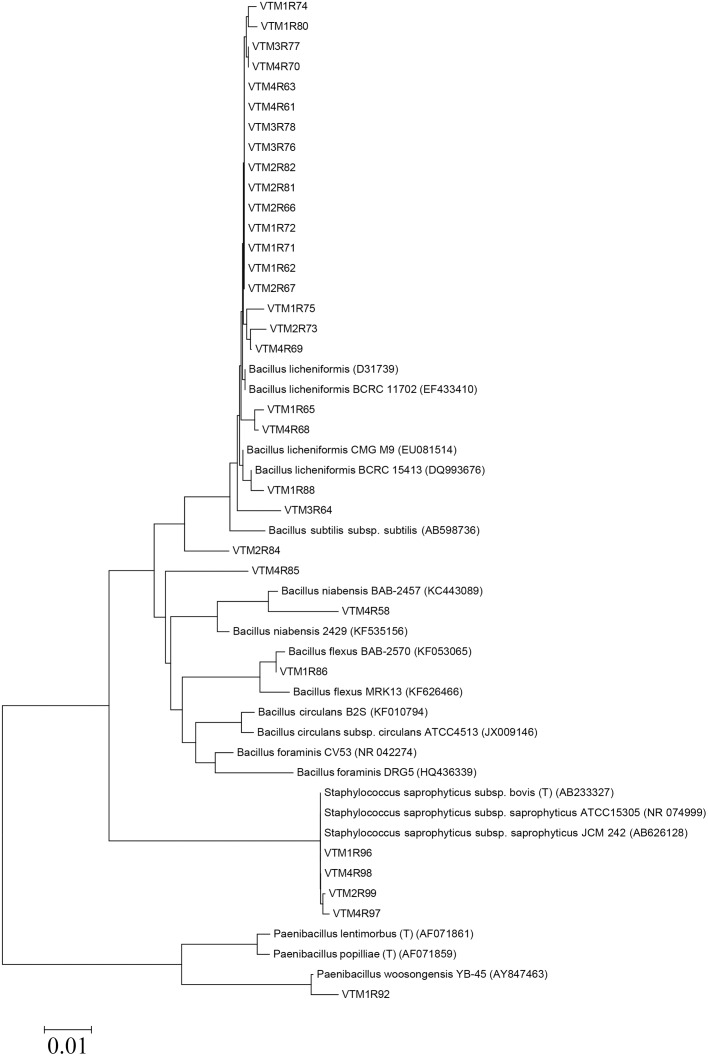
Phylogenetic comparison of 31 fibrolytic isolates along with known sequences (NCBI).A neighbor-joining tree was created using MEGA ver. 6 and the Kimura 2-parameter model. The asterisk (*) indicates the five probiotic isolates, and the one potential probiotic strain which could not be grown in continuous culture.